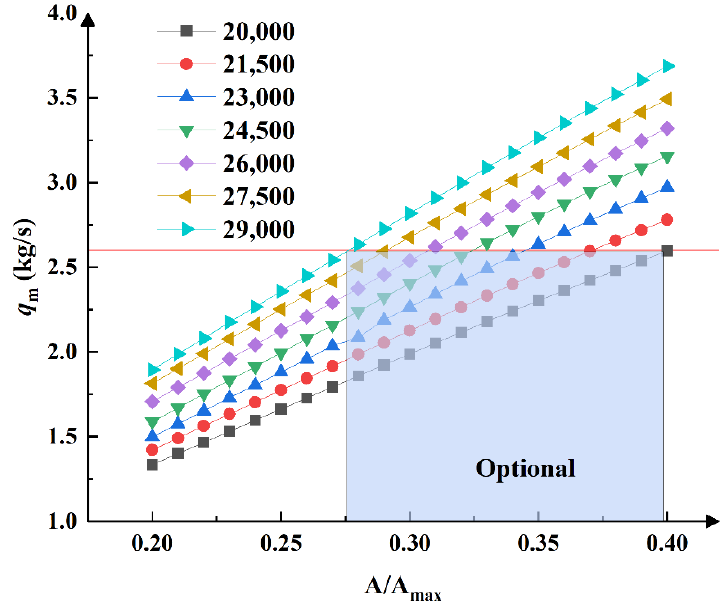
Figure 16. Mass flow vs. speed and valve opening under low operating conditions.